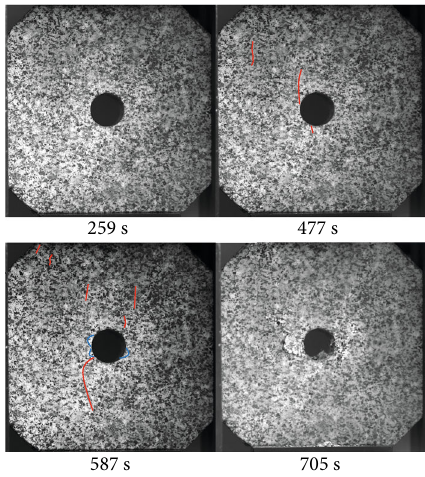
Figure 8: Crack evolution characteristics during biaxial compression experiment (note: microcracks marked with red lines, macrocracks marked with blue